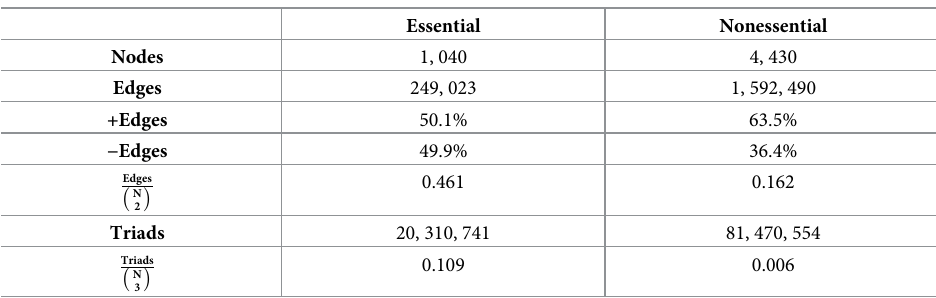
Table 2. Dataset statistics.